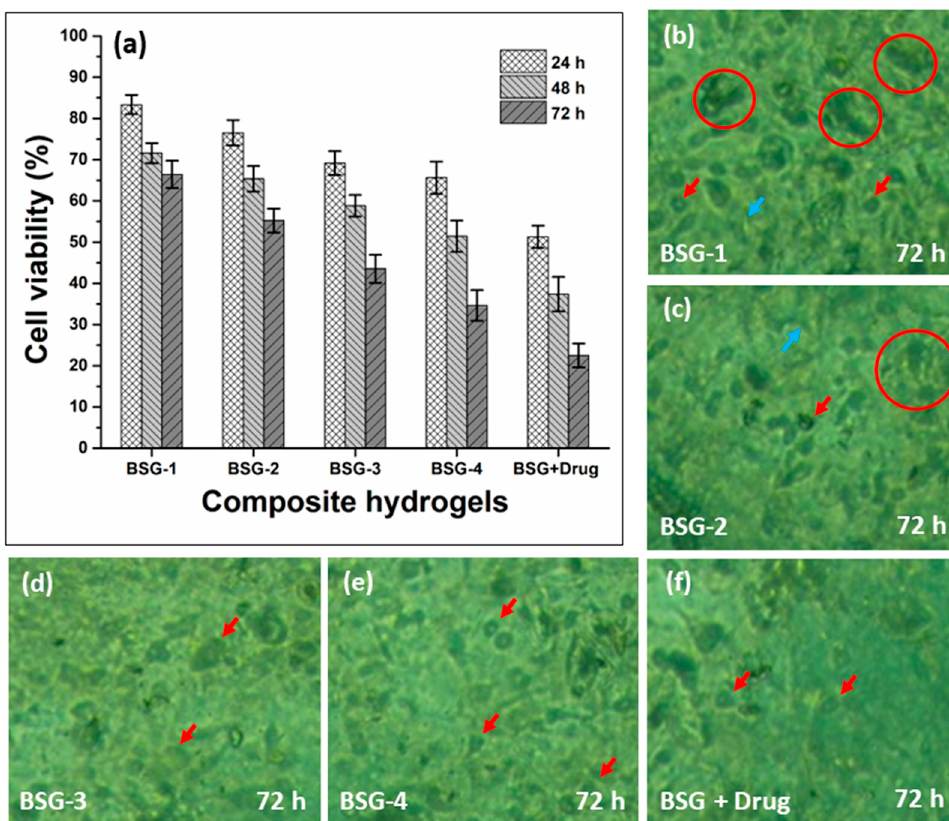
Figure 8. The anticancer activities of composite hydrogels against U87 cell line, ( a ) cell viability in terms of anticancer activities, and ( b – f ) cell morphology with different indications. terms of anticancer activities, and ( b – f ) cell morphology with different